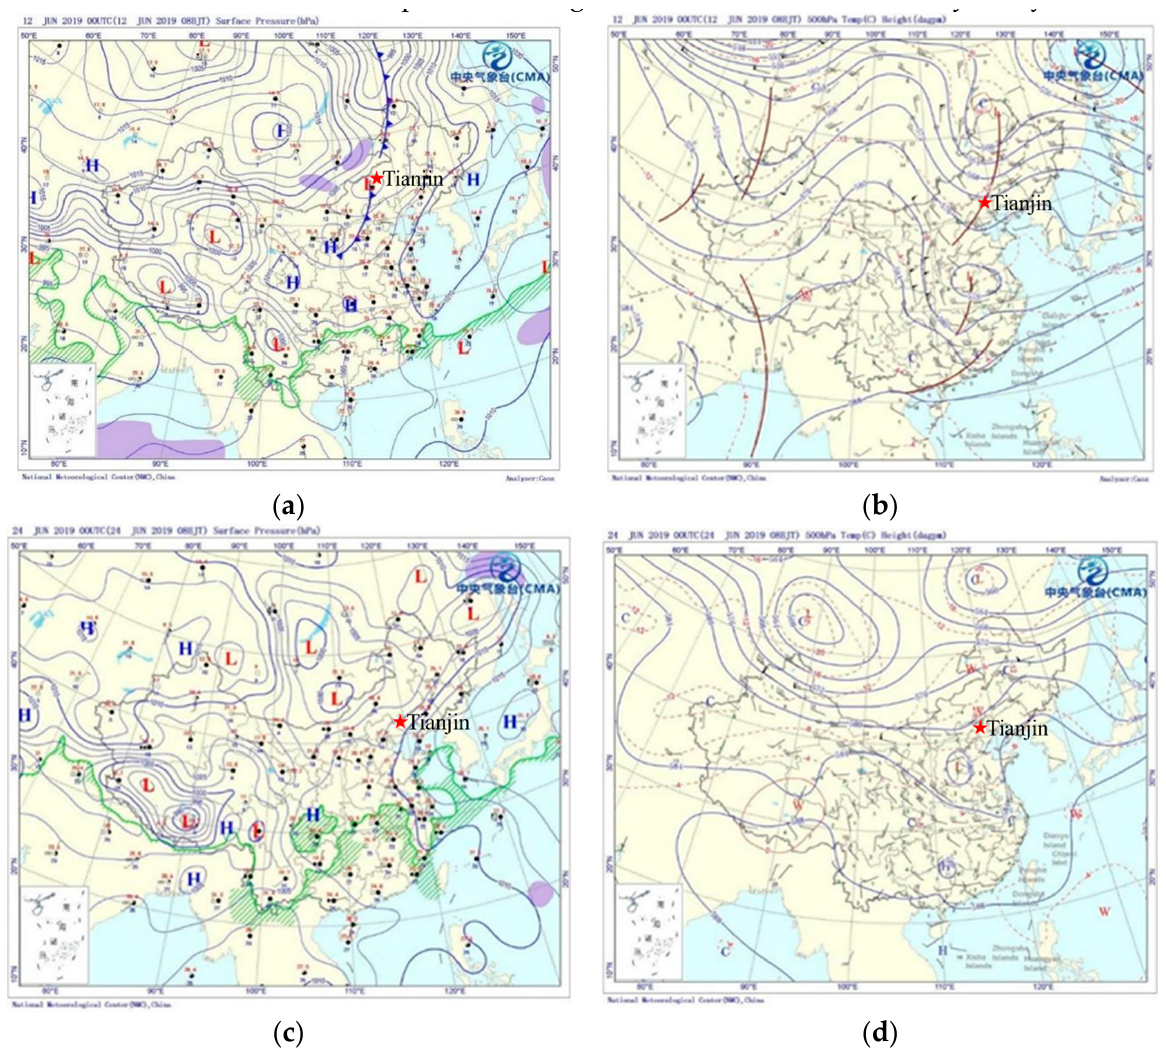
Figure 5. ( a ) Surface weather map and ( b ) 500 hPa weather map at 08:00 on June 12. ( c ) Surface weather map and ( d ) 500 hPa weather map at 08:00 on June